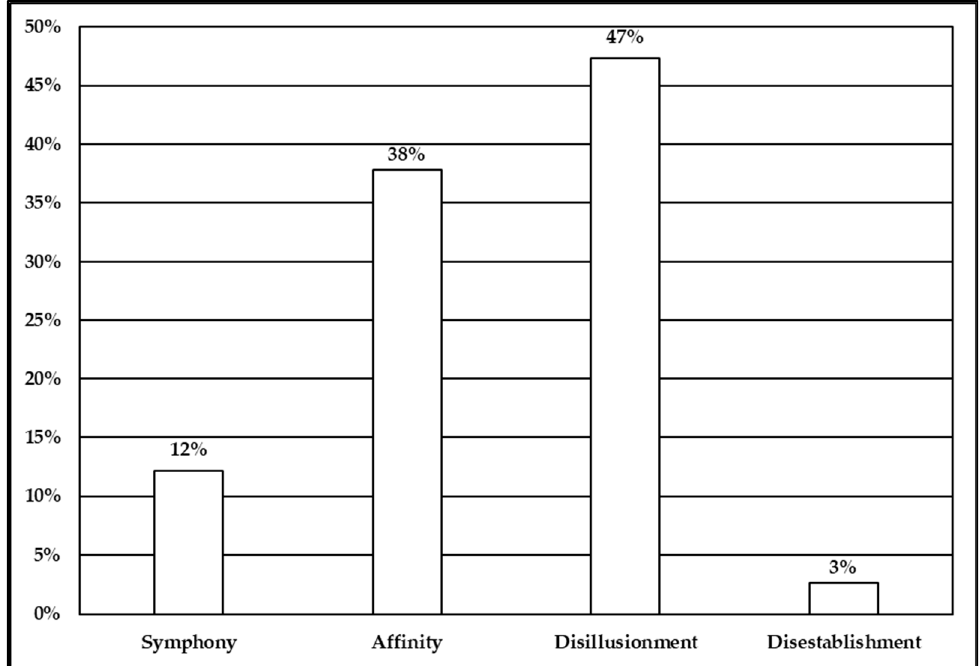
Figure 4. Dominant church-state relations frames, % of articles where found. Of the articles published on Pravoslavie.Ru that included church-state relations frames, the majority (45.8 percent) had a dominant affinity frame, with disillusionment taking second with 37.5 percent, symphony frames in third place with 12.5 percent, and disestab- lishment frames in fourth place with 4.2 percent. Among the articles including church-state relations frames published on Foma.Ru, the majority (40 percent) had a dominant disillu- sionment frame, while symphony, affinity, and disestablishment dominant frames were tied for second place with 20 percent each. Of the articles published on Pravmir.Ru, the majority of those that included church-state relations frames had dominant disillusionment frames with 50 percent, followed by affinity frames in second place with 33.8 percent, and symphony frames in third place with 14.9 percent; disestablishment frames sat in last place with only 1.4 percent. Among the articles published on Ruskline.Ru with church-state relations frames, disillusionment frames were in first place with 48.9 percent, followed closely by affinity frames with 42.2 percent. Symphony frames were in a distant third with 6.7 percent, and disestablishment frames were in last place with 2.2 percent (see Figure